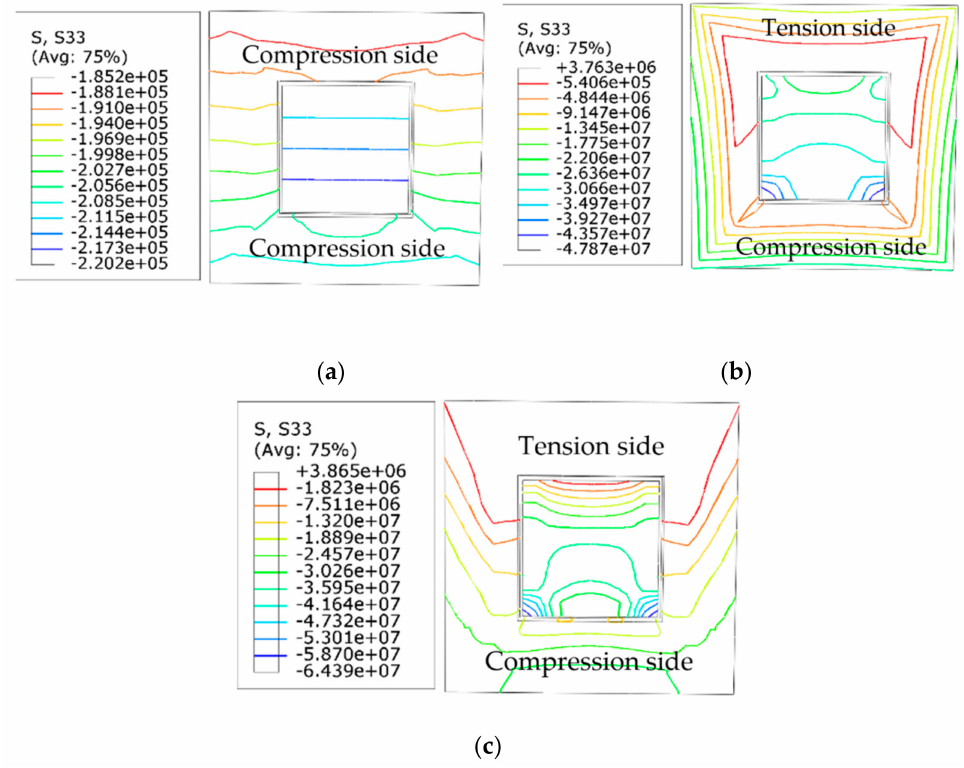
Figure 12. Stress distribution at different times of fire at the half-height section ( a ) t = 0 min; ( b ) t = 30 min; ( c ) t = 56